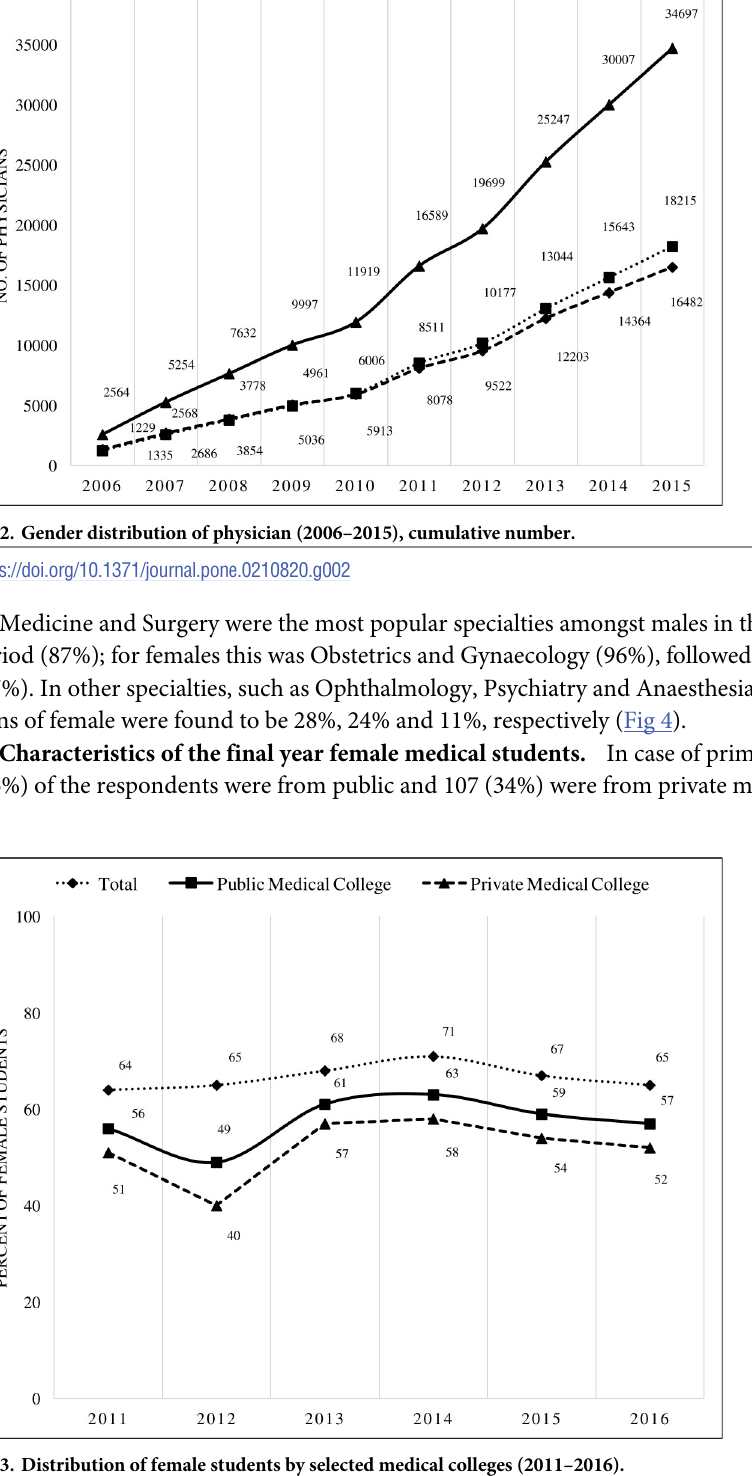
Fig 3. Distribution of female students by selected medical colleges